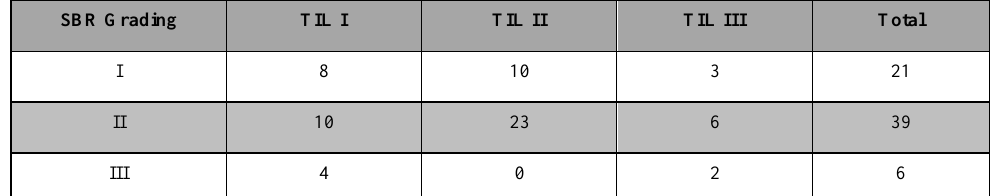
Table 5. TIL Score correlation with SBR grading.